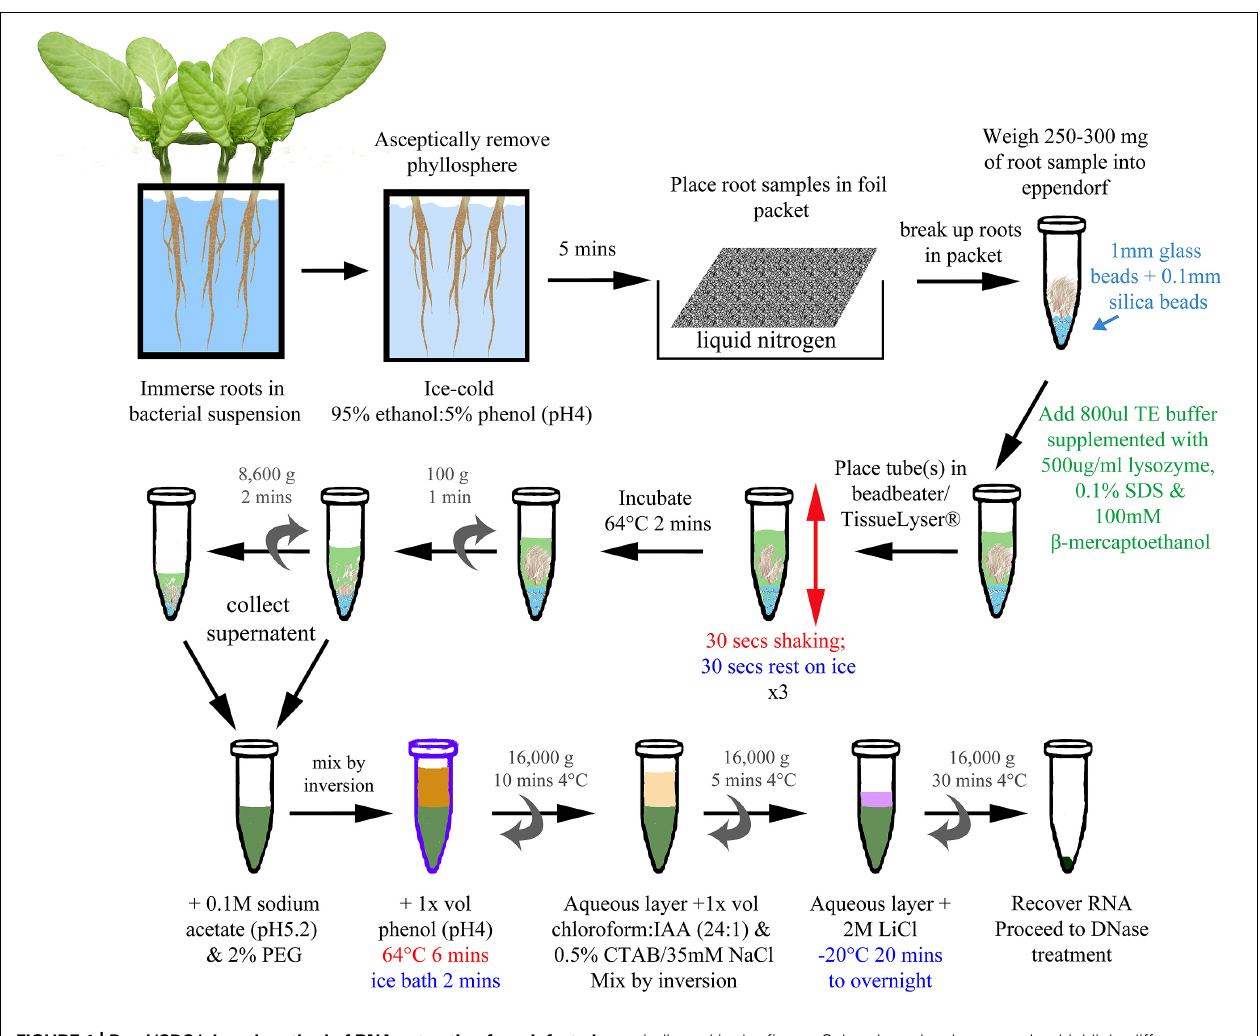
FIGURE 1 | Bead/SDS/phenol method of RNA extraction from infected plant roots. A schematic of the optimized method (described in detail within Section “Material and Methods”).The final concentrations of reagents are